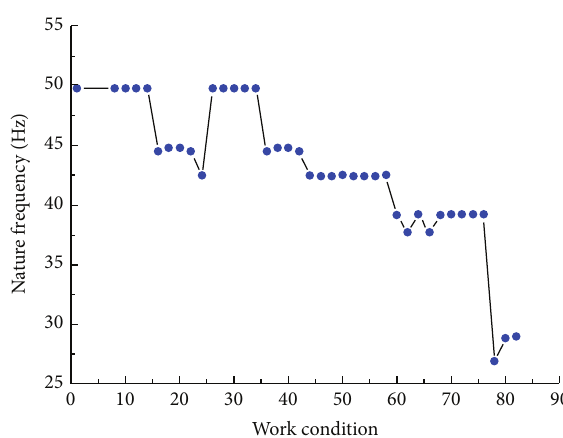
Figure 15: Natural vibration frequency change trend curve.